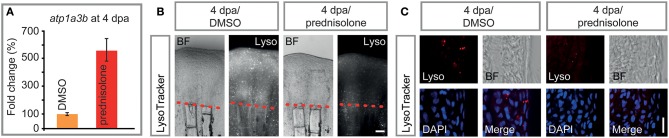
Impaired ATPase expression and lysosomal acidification. (A) qRT-PCR on atp1a3b, a sodium/potassium ATPase subunit. Mean and SD (technical error). (B) Live whole mount view of LysoTracker stained 4 dpa fin regenerates. Scale bar 100 μm. n = 5. (C) Longitudinal section view of fixed LysoTracker stained fin regenerates at 4 dpa. Scale bar 10 μm. BF, brightfield; Lyso, LysoTracker. n = 5, 5 sections minimum per fish.